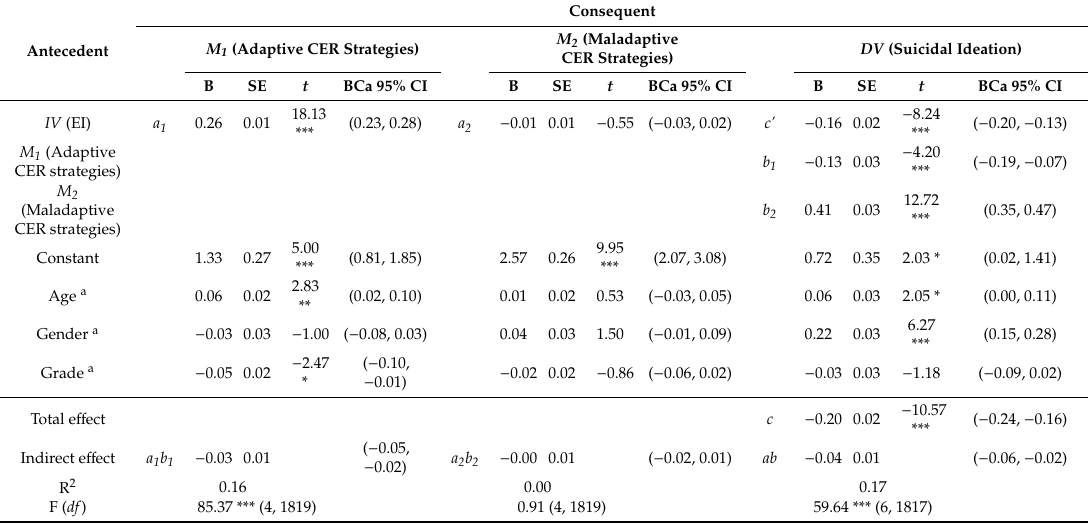
Table 2. Summary of the indirect effects between EI and suicidal ideation through CER strategies (Study 1).